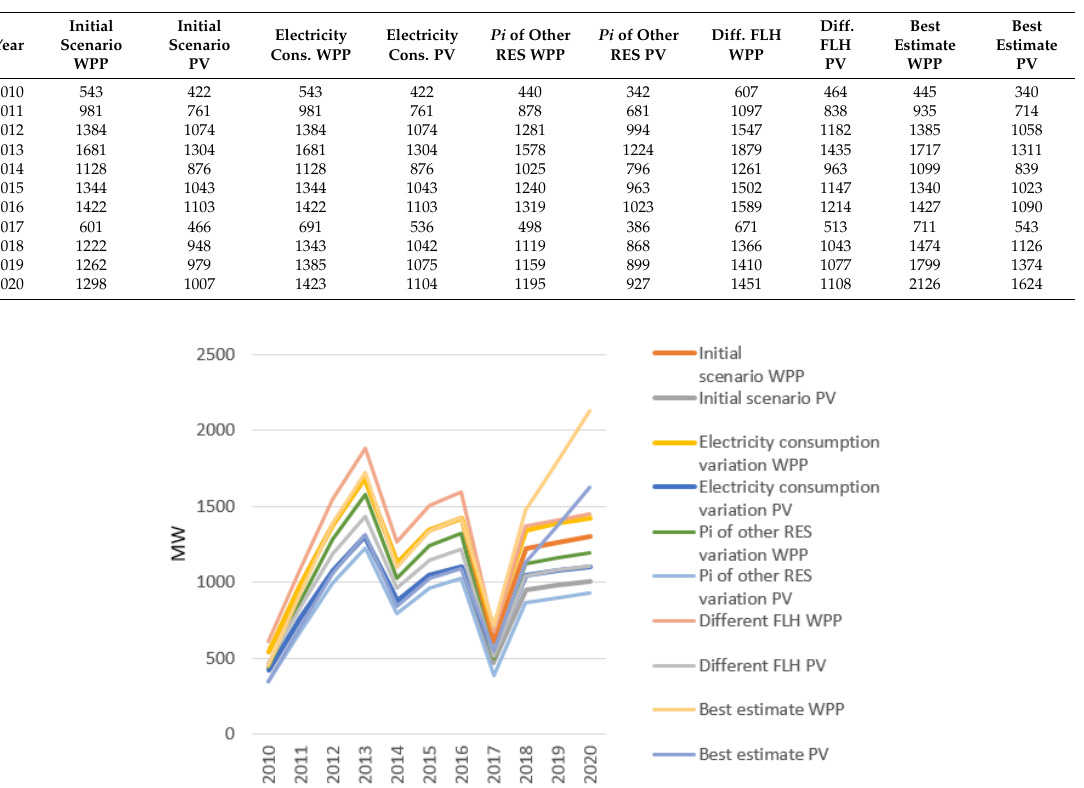
Table 9. Pi of WPP and PV in different scenarios.